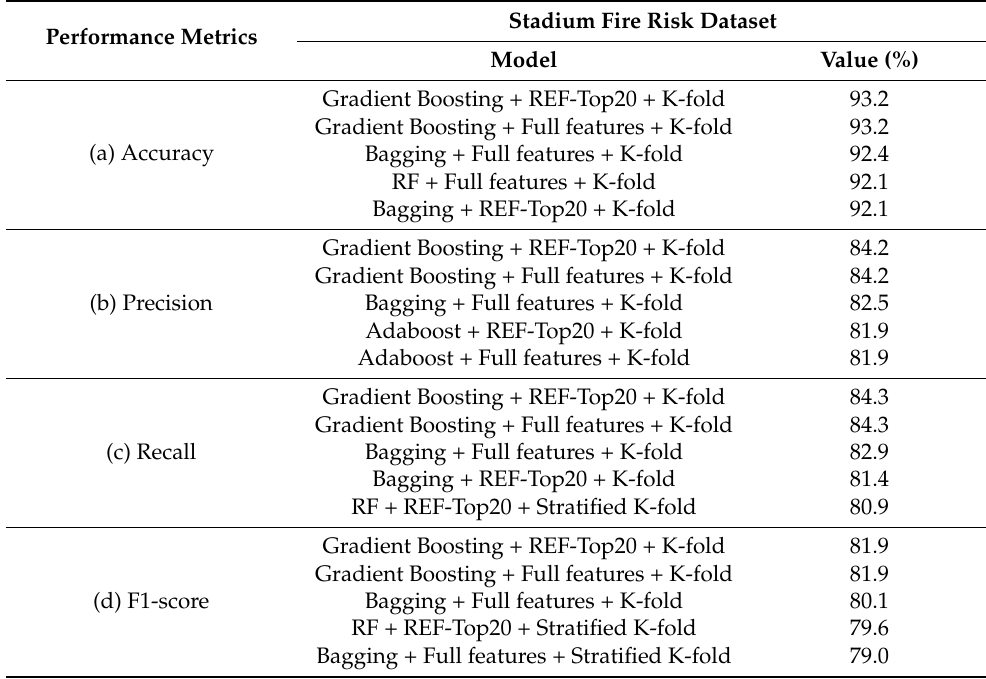
Table 8. Performance Analysis of Six Risk Prediction Classification